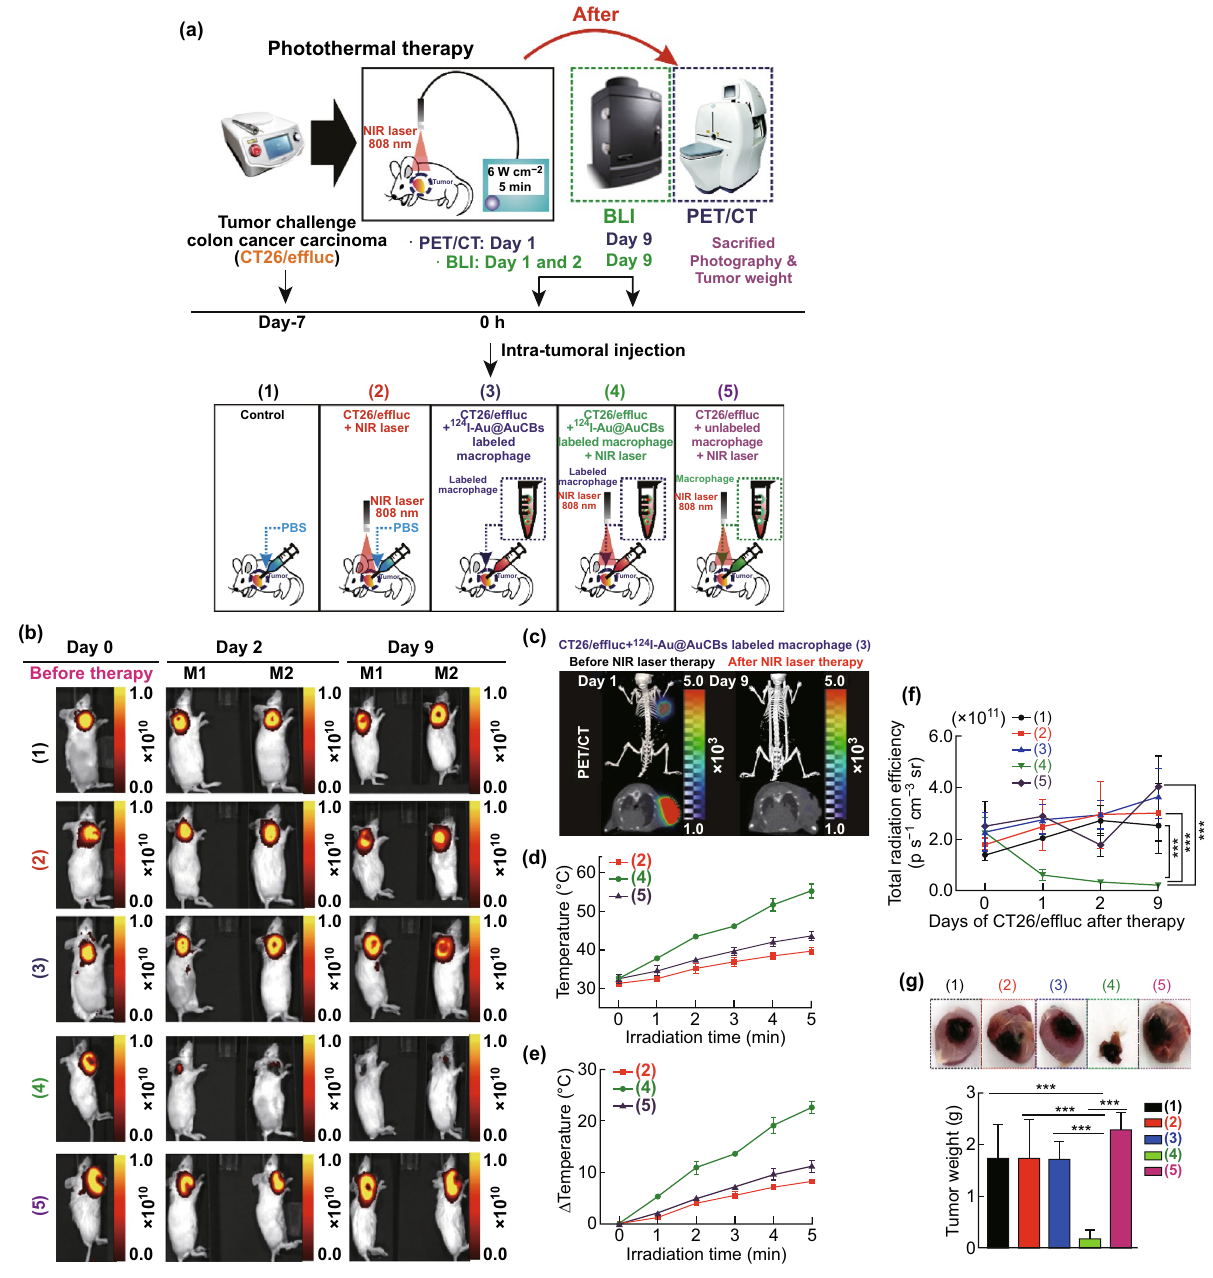
Fig. 6 Ablation of colon cancer by 124 I‑Au@AuCB‑labeled macrophage‑mediated PTT. a Scheme for 124 I‑Au@AuCB‑labeled macrophage‑ mediated PTT in vivo. In vivo PET/CT imaging of CT26/FM tumor‑bearing mice, intratumorally injected with 124 I‑Au@AuCB‑labeled mac‑ rophages. Experimental groups: (1) control, (2) laser alone, (3) 124 I‑Au@AuCB‑labeled macrophages, (4) 124 I‑Au@AuCB‑labeled mac‑ rophages + laser‑treated, and (5) macrophages + laser‑treated. b In vivo FLI showing the therapeutic response to 124 I‑Au@AuCB‑labeled macrophage‑mediated PTT. c PET/CT imaging of CT26/FM tumor‑bearing mice administered either unlabeled or labeled macrophages and subsequently irradiated with an NIR laser (6 W cm −2 , 5 min). d Temperature and e temperature changes ( Δ temperature) in CT26/FM tumors, before and after irradiation with an NIR laser (6 W cm −2 , 5 min). f Quantification of FLI signals in CT26/FM tumors, before and after PTT. g Photograph of an excised CT26/FM tumor and determination of tumor weight from respective groups. In vivo experiments were performed in duplicate ( n = 7 mice per group). ***P <